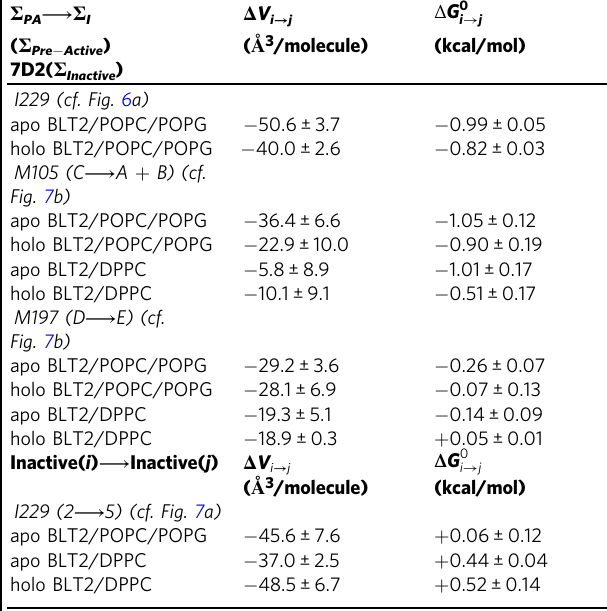
Table 1 Quantitative analysis of volume and free energy differences induced by pressurization between the sum of the pre-active ( Σ PA ) and inactive ( Σ I ) states for I229, M105, and M197 residues (Top) and between I229 2 and 5 inactive states (Bottom) (data derived from Fig. 7) and directly related to the populations displayed in Fig. 8 in a pressure range where variations in populations were